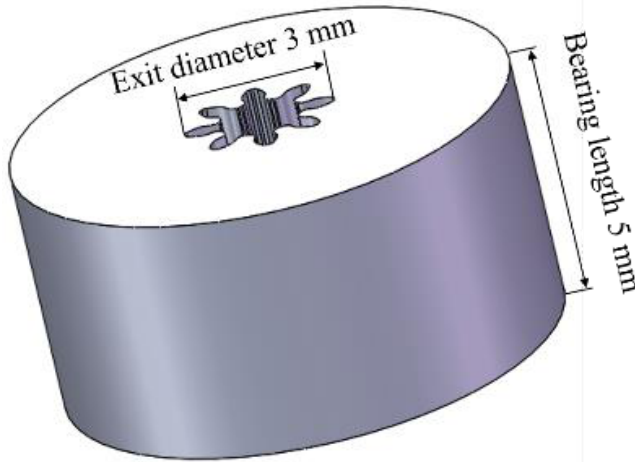
Figure 4. The bearing length and exit diameter of the concave Figure 4 . The bearing length and exit diameter of the concave die.